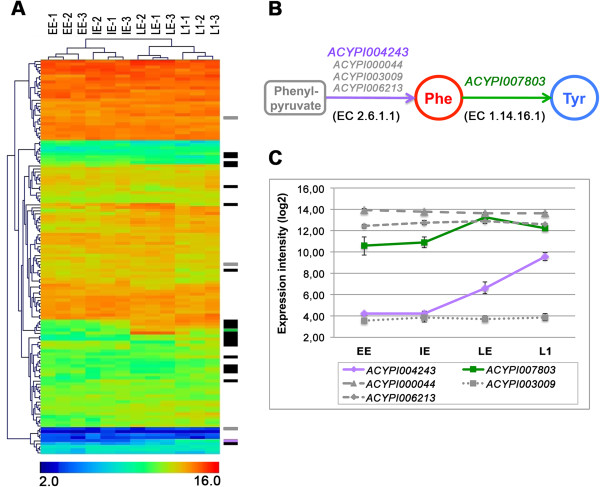
Amino acid metabolism gene expression profiling during pea aphid development. A) Hierarchical clustering (generated by an average linkage method with euclidean distance and no leaf order optimization) of the 135 amino acid metabolism genes annotated by Wilson et al.[29]. The colour chart indicates expression intensities using a base 2 logarithmic scale: blue and red represent, respectively, the lower (2.0) and upper (16.0) expression intensities (see bottom panel legend). On the right of the cluster we reported: in black, the genes varying significantly in at least one of the comparisons, with the exception of the ACYPI007803 gene, shown in green, and ACYPI004243, shown in purple. The three other genes coding the 2.6.1.1 enzyme activity are highlighted in grey but do not vary significantly during development. B) Final steps of the pathway for phenylalanine and tyrosine biosynthesis encoded in the pea aphid genome. C) Expression profiles of the genes involved in the pathway for phenylalanine and tyrosine biosynthesis in the pea aphid. Expression intensity is given as log2. Expression intensities of each stage are means of the three biological replicates.